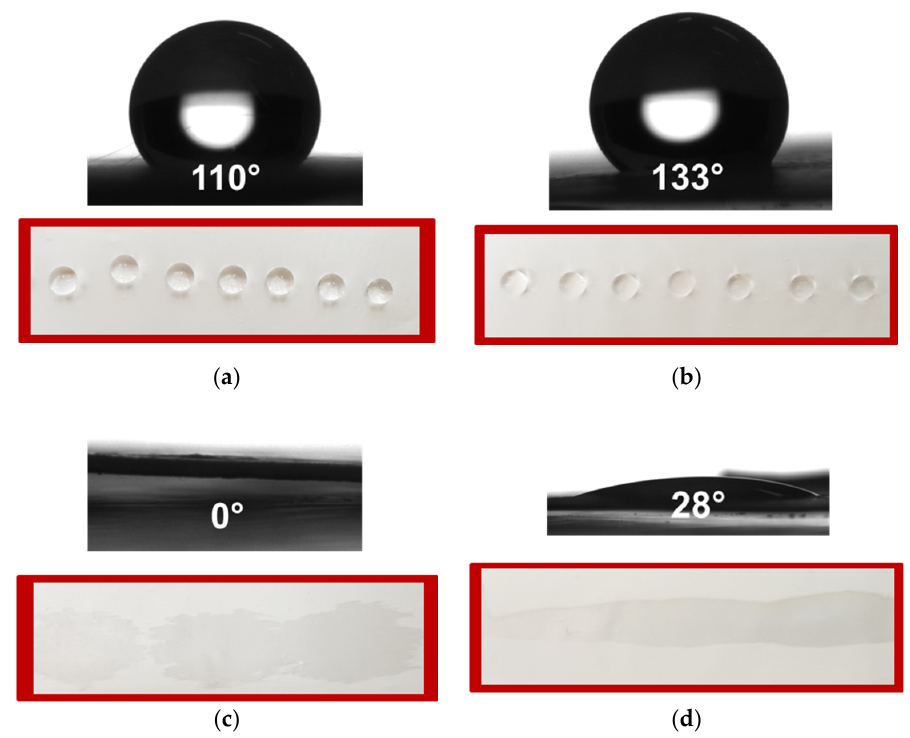
Figure 4. Digital images of distilled water drops (10 μL) placed on surfaces of fibrous mats based on: ( a ) PLA, ( b ) PLA/ M. officinalis (10 wt%), ( c ) PLA/PEG and ( d ) PLA/PEG/ M. officinalis (10 wt%)